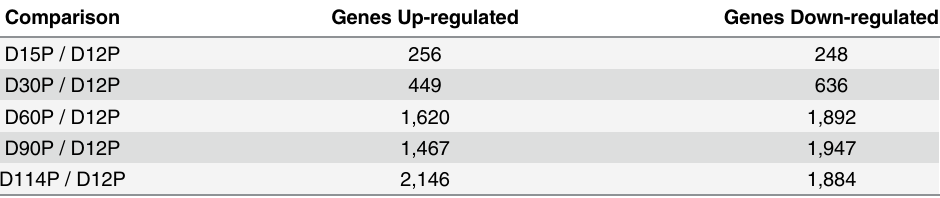
Table 2. Number of differentially expressed genes at different stage of gestation compared to the genes expressed on day (D) 12 of pregnancy (P) in the uterine endometrium in pigs.